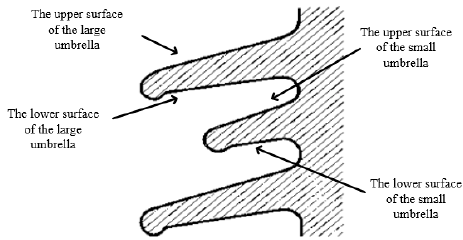
Figure 1. Schematic diagram of the insulator sheds.